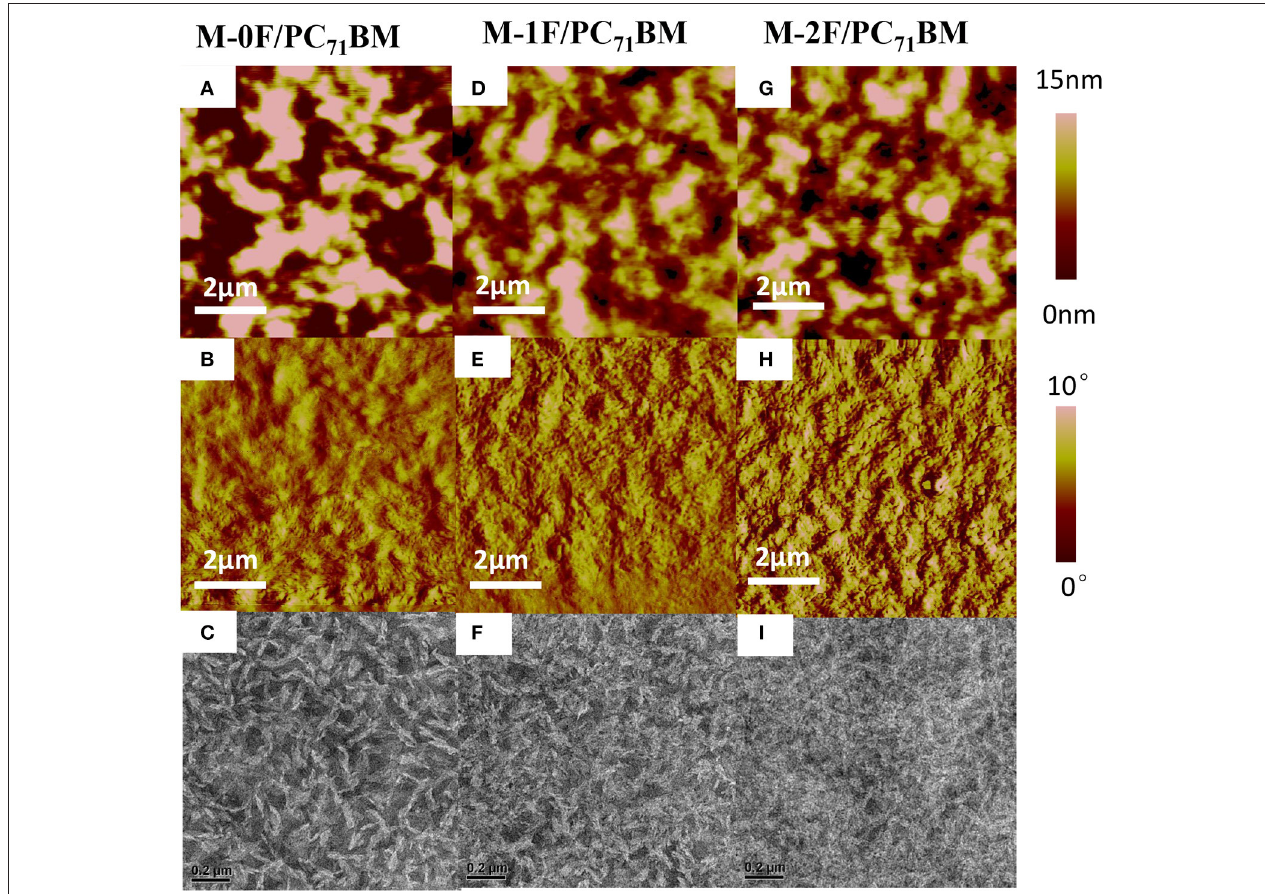
FIGURE 3 | Tapping-mode AFM (A,D,G) topography and (B,E,H) phase images and (C,F,I) TEM images of (A–C) M-0F/PC 71 BM, (D–F) M-1F/PC 71 BM, (G–I) M-2F/PC 71 BM blend films.